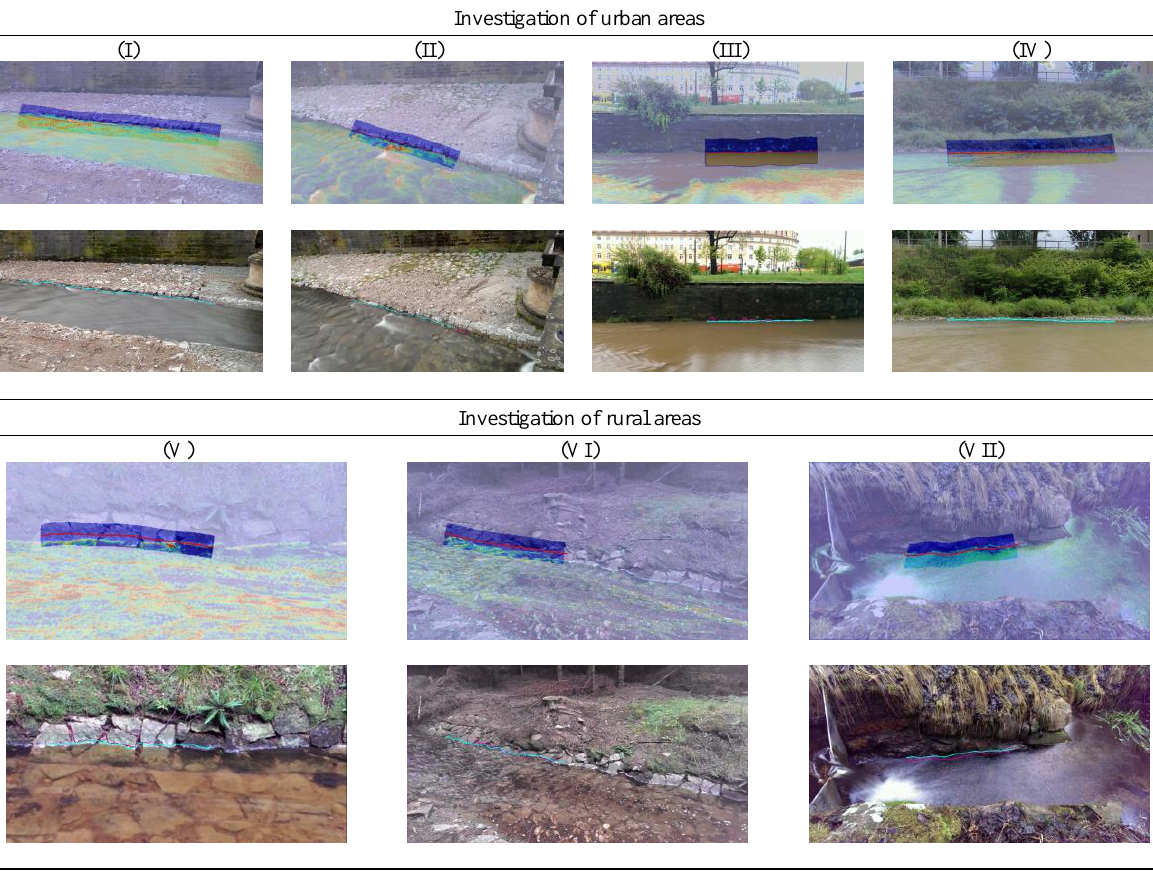
Table 3. Experimental investigations of water lines using the spatio-temporal texture (urban study areas (I) & (II)) and rural areas (V)-(VII)) or the average image (urban study areas (III) & (IV)) for image segmentation. Top rows: Overlay of average & spatio- temporal texture image containing masked ROI & initial shore line (red). Lower lines: determined water line using 3 fps (blue) & 5 fps (pink) for